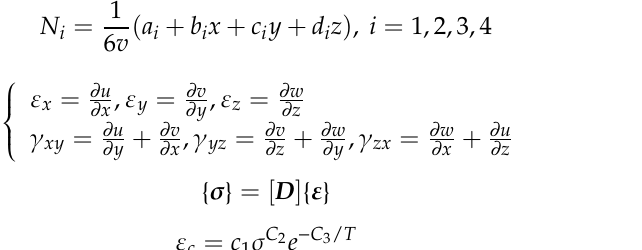
Figure 4. Finite element model of the disk. Figure 5. Distribution of blade creep stress. Figure 6. Distribution of disk creep stress.